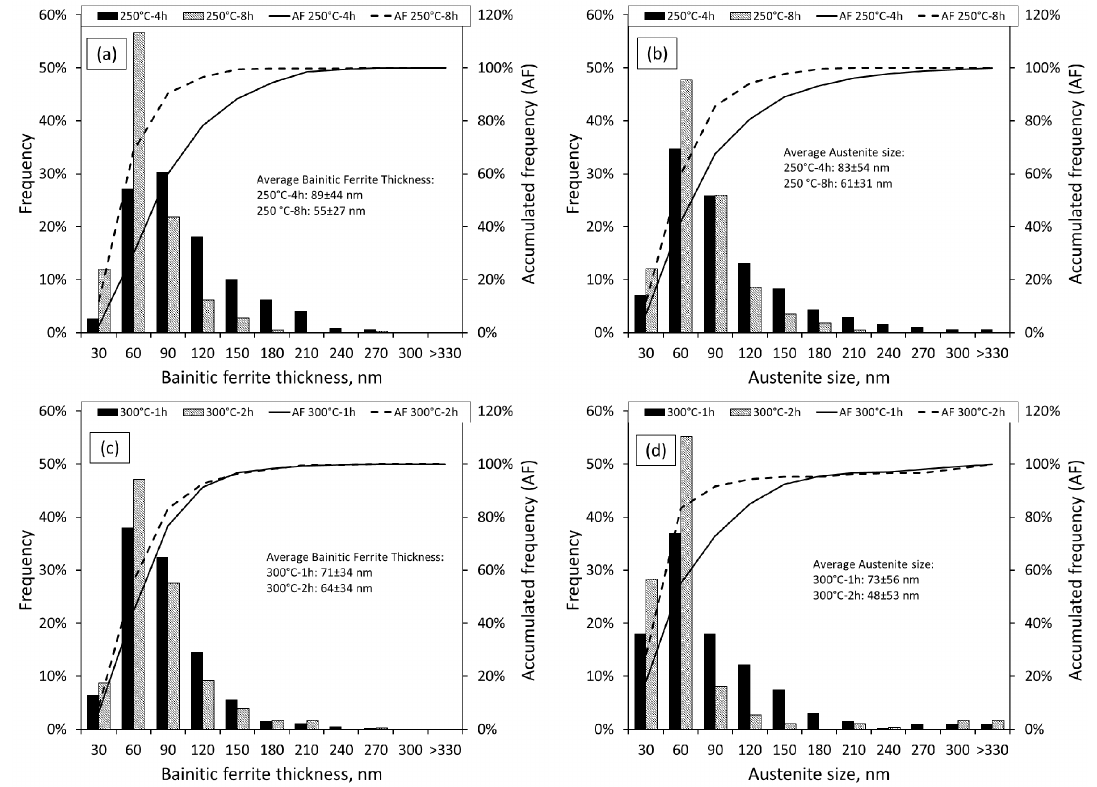
Figure 4. Size distributions: ( a ) Bainitic ferrite thickness at 250 °C, ( b ) retained austenite size at 250 °C, ( c ) bainitic ferrite thickness at 300 °C, and ( d ) retained austenite size at 300 °C.